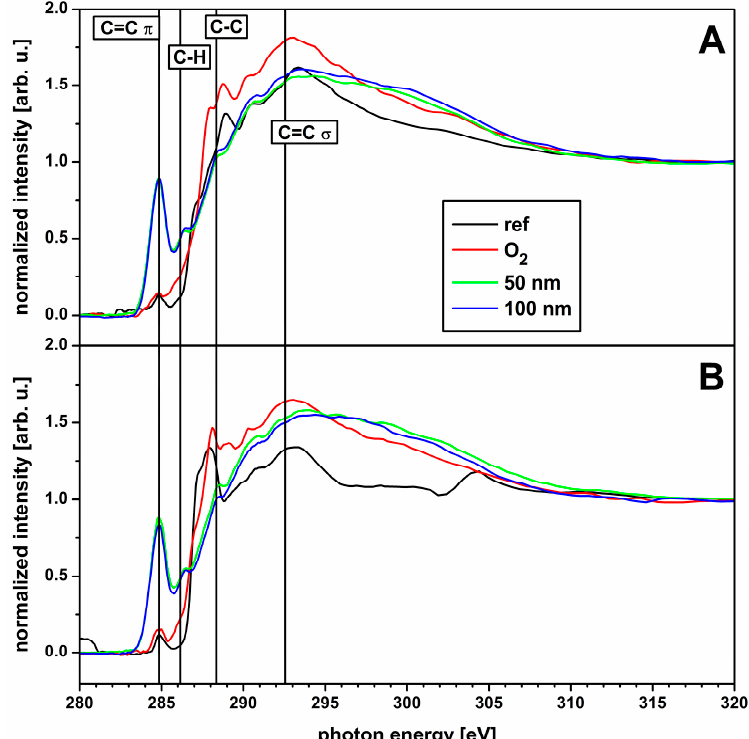
Figure 6. Results of the near edge X-ray absorption fine structure (NEXAFS) measurements for ( A ) CS and ( B ) CN–CS. Black is the respective raw polymer, red is the O 2 plasma treated, green is the 50 nm a–C:H, and blue is the 100 nm coated sample.